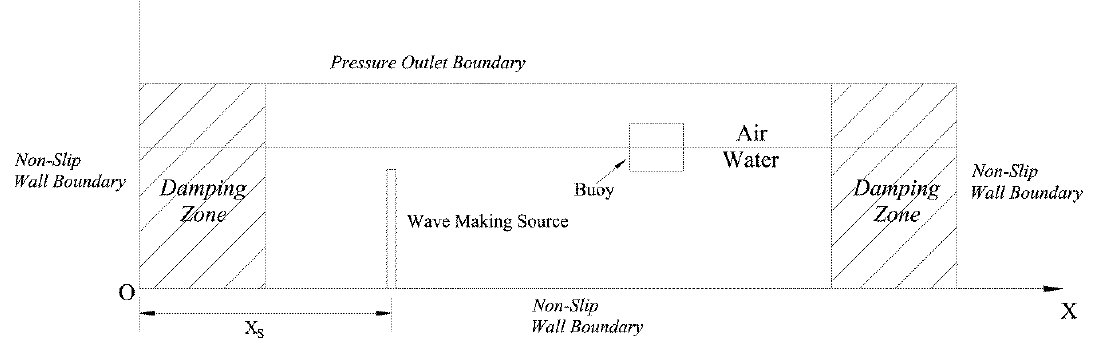
Figure 3. Schematic of Numerical Wave Tank.